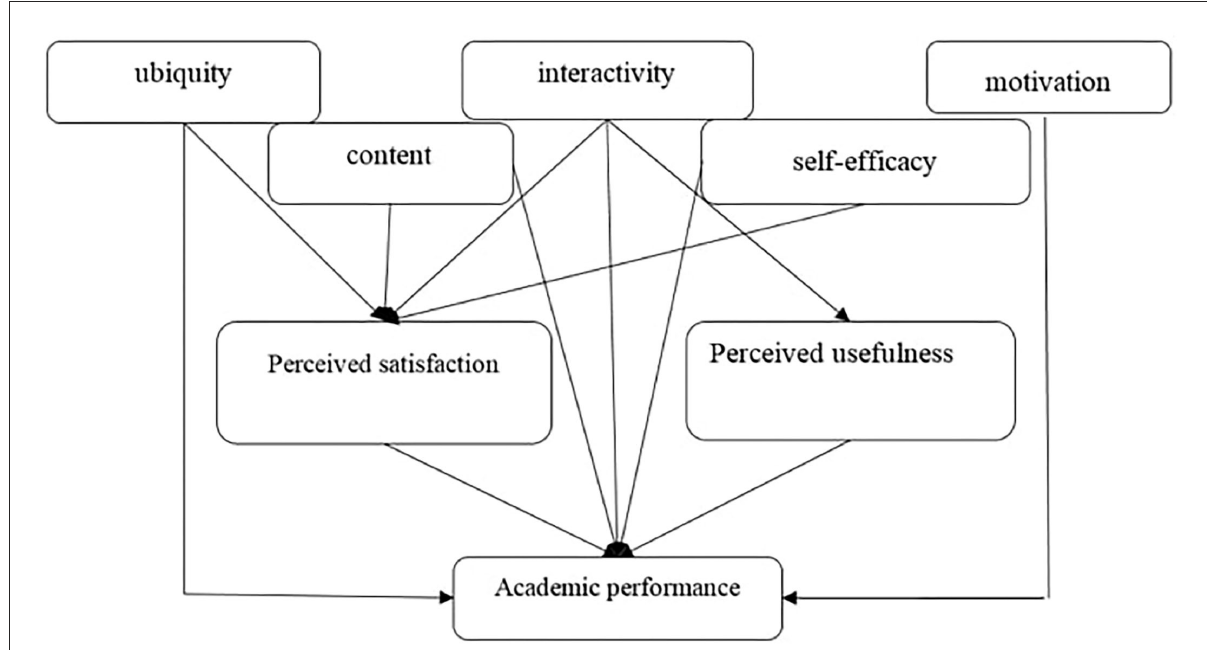
FIGURE1 Model for studying the relationship between academic achievement, perceived satisfaction, and usefulness and aspects of mobile learning such as ubiquity, content, interactivity, self-efficacy, and